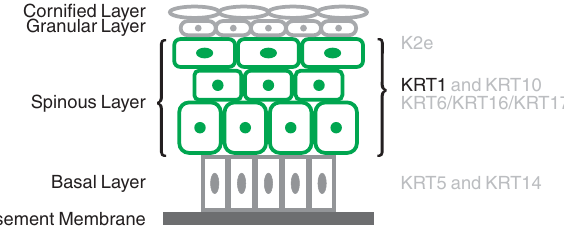
Figure 1. Expression of keratin genes in the stratified epithelium of the epidermis. As keratinocytes become post-mitotic and migrate through the epidermis from the basal into the spinous layer, KRT1 and KRT10 expression is up-regulated, replacing the expression of KRT5 and KRT14 [28,29]. These expression changes are controlled at the transcriptional level [30,31]. During terminal differentiation the kerati- nocytes migrate into the granular layer, and KRT1 and KRT10 are replaced by K2e [29]. During re-epithelialization in the wounded epidermis, cells preparing to migrate down-regulate KRT1 and KRT10 in favour of KRT6 , KRT16 , and KRT17 [2,3]. The repression of KRT1 is thought to be necessary for normal terminal differentiation and migration [28,29]. The figure is adapted from Porter and Lane [29].